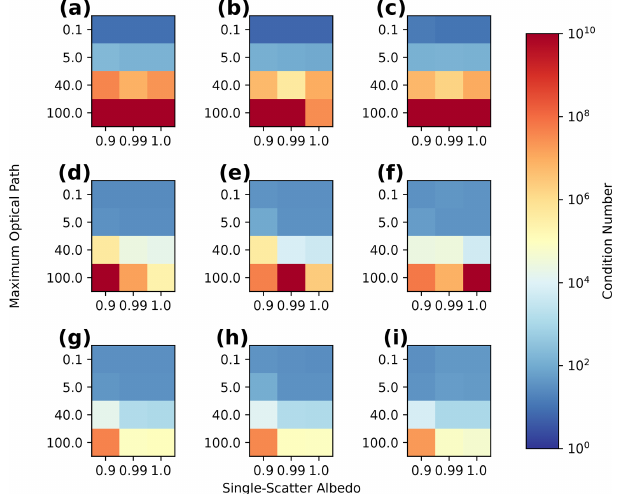
Figure 5. The condition number (see text for details) of the finite- differenced Jacobian for 3D Gaussian clouds with different combi- nations of single-scattering albedo and maximum optical path. Pan- els (a) , (b) , and (c) have isotropic phase functions. Panels (d) , (e) , and (f) have Mie phase functions, and panels (g) , (h) , and (i) have Mie phase functions with a reduced angular resolution (see text for details). Panels (a) , (d) , and (g) have a black surface. Panels (b) , (e) , and (h) have Lambertian surface albedos of 0.2, while panels (c) , (f) , and (i) have Lambertian surface albedos of 0.7. The crimson squares exceeding the color scale reach 10 16 .